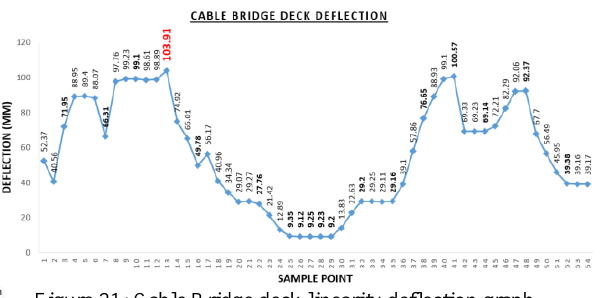
Figure 21: Cable Bridge deck linearity deflection graph